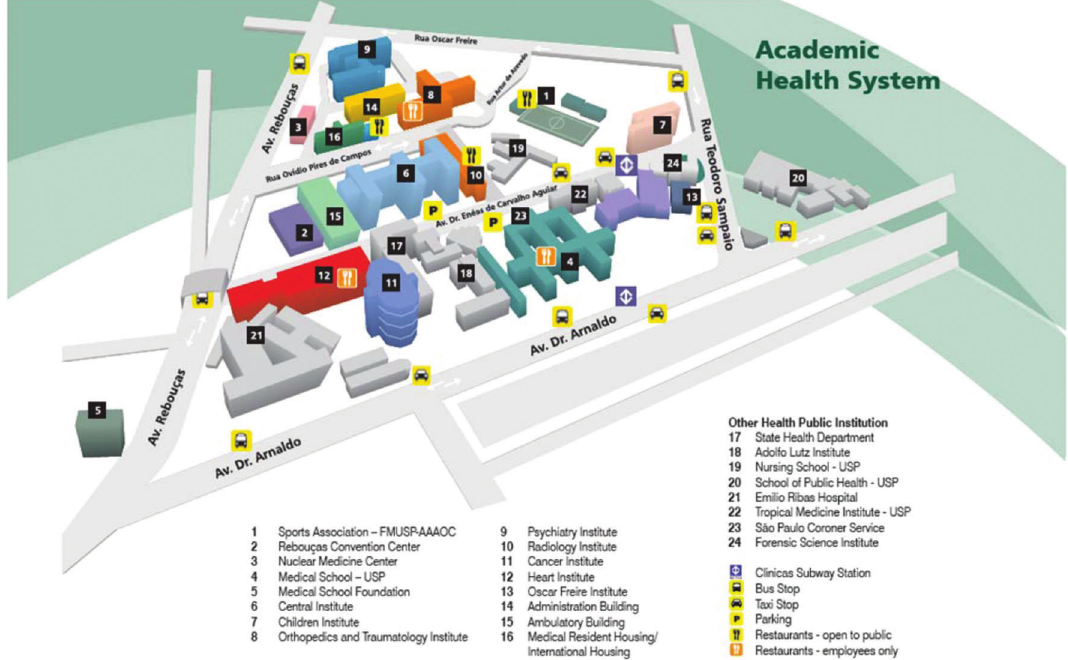
Figure 1 - The Hospital das Clı´nicas da Faculdade de Medicina da Universidade de Sa˜o Paulo (HCFMUSP)